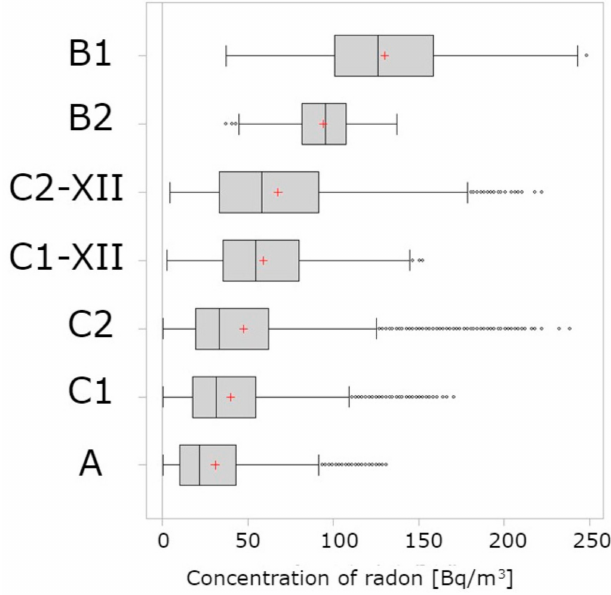
Figure 1. Box plot of radon concentrations in individual measurement